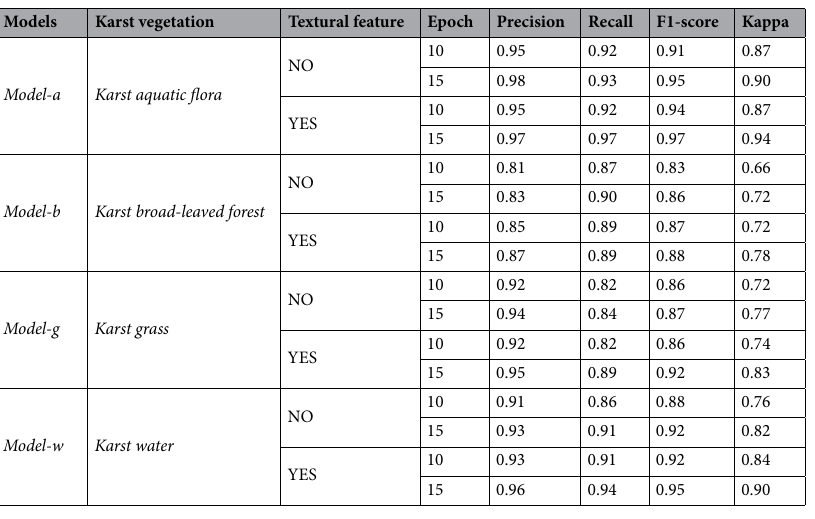
Table 5. Classification accuracy of single-class SegNet models with texture feature and different EPOCH values in area